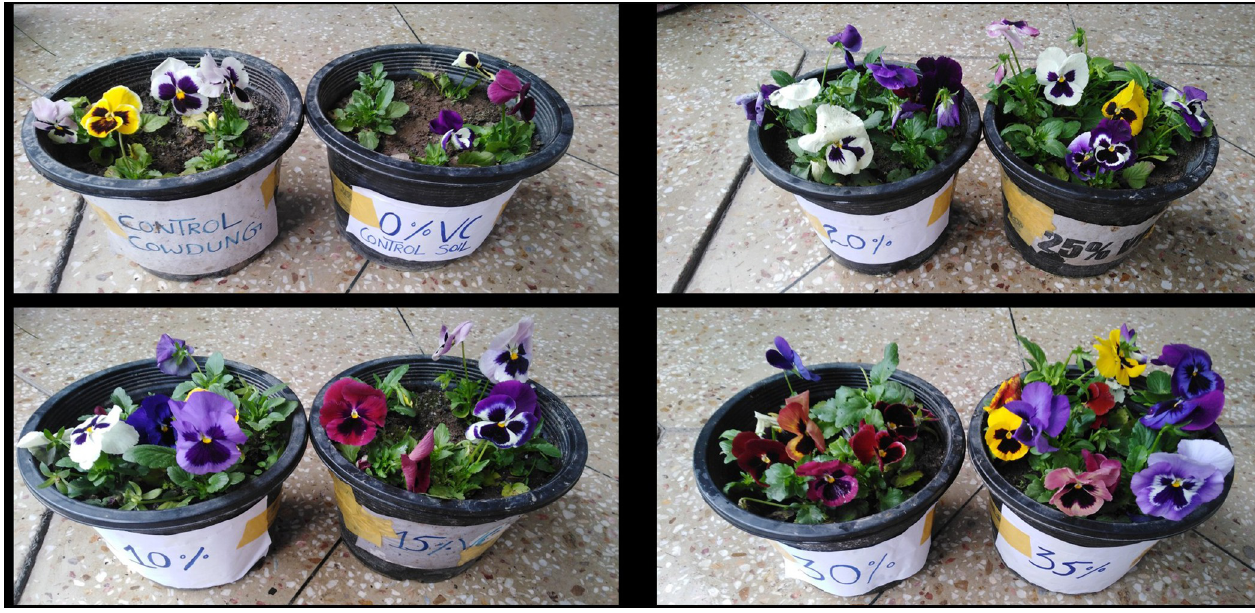
Fig 3. Influence of vermicompost based germinating media on vegetative growth of pansy at 15 th week of transplantation. https://doi.org/10.1371/journal.pone.0279828.g003 2.33 ± 0.23 g and 1.83 ± 0.23 g. The maximum dry weight (7.2 ± 0.08) of flowers was observed in 35% VC whereas To and Tcc showed the minimum dry weight of flowers i.e. 0.3 ± 0.00 g and 0.1 ± 0.00 g respectively. From the whole results, we can say that for the development of plant growth parameters 35% VC germinating media is the best media as shown in Fig 3.